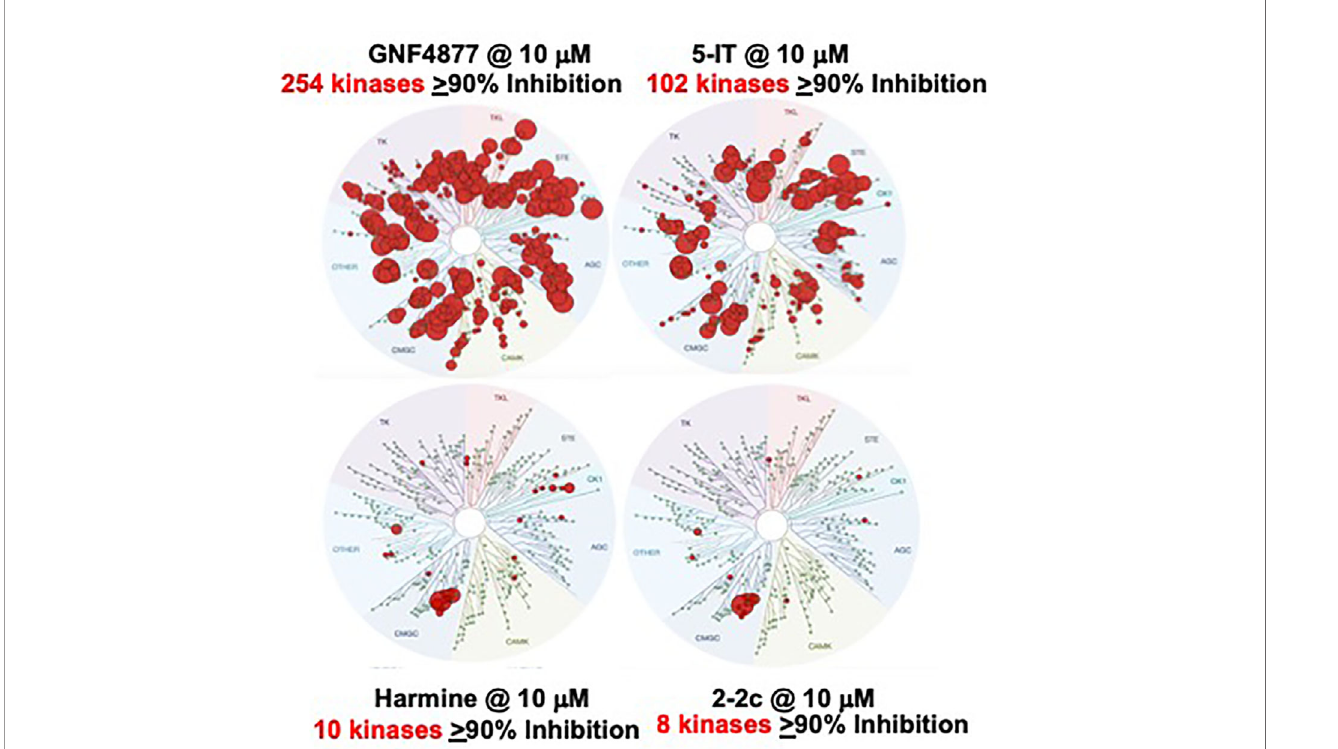
FIGURE 10 | Kinome Scans for Representative Beta Cell Regenerative DYRK1A Inhibitors. GNF4877, 5-IT, harmine and Compound 2-2c were assayed for binding interactions with a standard panel of 468 human protein kinases from DiscoverX, all at the same concentration, 10 µM. Compare to Figure 4 . GNF4877 and 5-IT are the most potent activators or human beta cell proliferation, but have poor DYRK1A speci fi city. GNF2133 is also a potent activator of proliferation, but has poor kinase speci fi city, even in a limited kinome scan (55). Among published data, compound 2-2c has the greatest human beta cell proliferation ability with the highest DYRK1A speci fi city. It has the additional advantage of not being able to enter the CNS, and avoids serotoninergic and adrenergic G-protein coupled receptors. Adapted from (51, 52), which contain complete